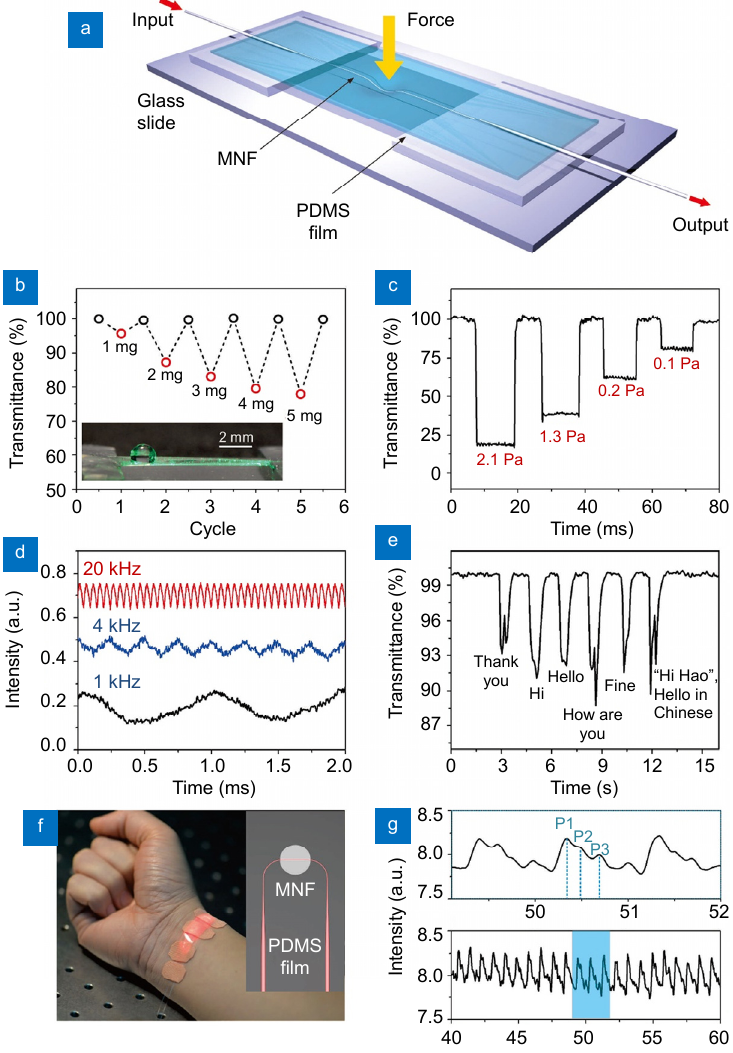
Fig. 3 | Characterization of suspended SLWOSs. ( a ) Schematic of testing suspended SLWOS. ( b ) Response of a suspended SLWOS to water droplets with different weights. The inset shows an optical micrograph of the SLWOS with a water droplet atop. ( c ) Response of a suspended SLWOS to pressure of 2.1, 1.3, 0.2 and 0.1 Pa, respectively. ( d ) Temporary response of a suspended SLWOS to forced oscillation frequencies of 1, 4 and 20 kHz, respectively. ( e ) Response of a suspended SLWOS to acoustic vibrations from human voice. ( f) Photograph showing a SLWOS directly above the artery of the wrist. The inset shows a schematic of the SLWOS. ( g ) Measurement of wrist pulse under normal-condition (66 beats per